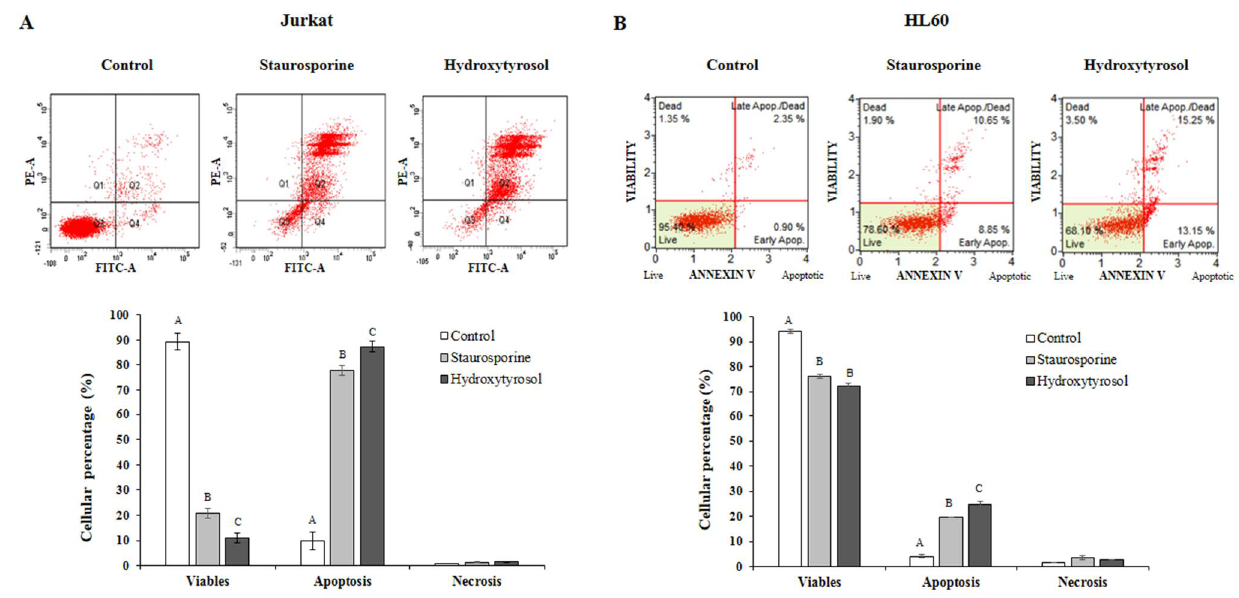
Figure 4. Effect of hydroxytyrosol on cell apoptosis levels in Jurkat (panel A ) and HL60 (panel B ) cell lines. Apoptosis values were obtained using flow cytometry. A positive control in the presence of staurosporine (1 µ g · mL − 1 ) was used. Panel A corresponds to Jurkat cells and panel B to HL60 cells. Cells were treated with hydroxytyrosol IC 50 for 24 h for Jurkat and 72 h for HL60 cells. Top: Fluorescence diagrams from a representative experiment are depicted and show the effect of hydroxytyrosol on different cell states, viability, early apoptosis, late apoptosis, and necrosis (Jurkat panel A and HL60 panel B). Below: the percentage of cells in each of these states are represented. Values are expressed as mean ± SEM ( n = 3). Different capital letters indicate the existence of significant differences ( p < 0.01). Quadrants: Q1, necrosis; Q2, late apoptosis; Q3, living cells; Q4, early apoptosis.